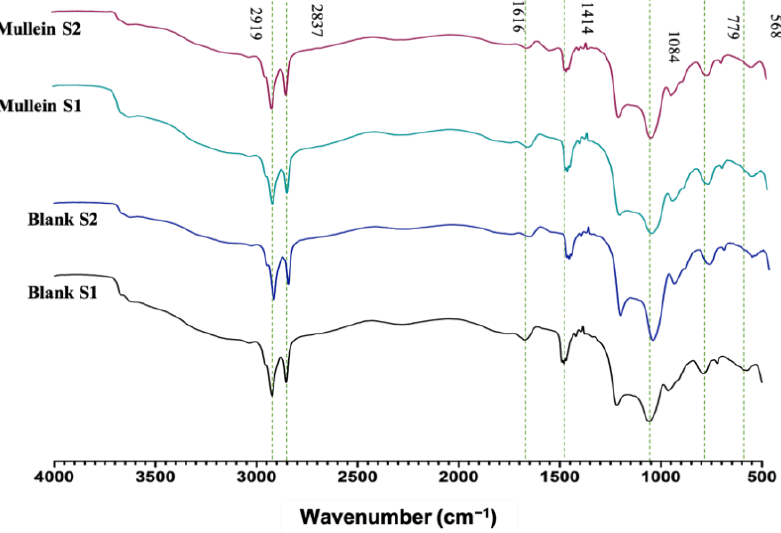
Figure 4. FTIR of silica – gold nanoparticles.